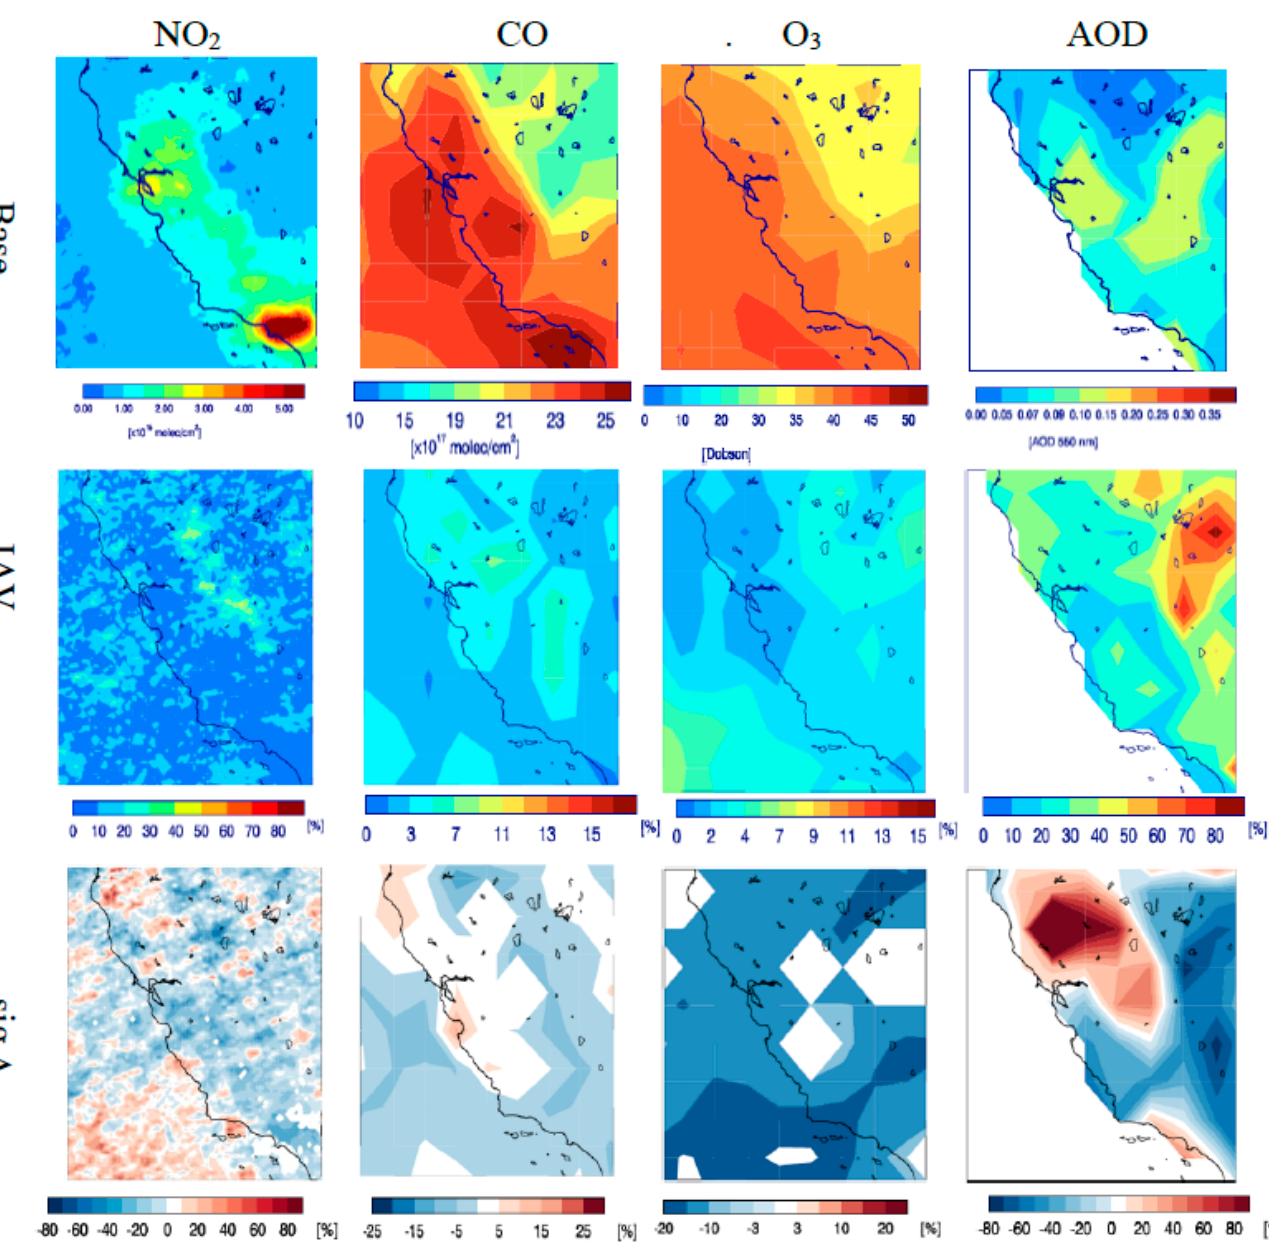
Figure 10. Same as Figure 3 but for the western coast. Tropospheric ozone column levels can reach up to 43 DU on the western coast with relatively low IAV of up to 1%–2% on San Francisco and Los Angeles. Reductions in the ozone tropospheric column during the lockdown period is within 15% over San Francisco and Los Angeles (see Figures 5 and 10). As aforementioned, ozone is a photochemical product, and the increase of NO 2 (north of San Francisco) under high-NO x conditions also decreases O 3 formation. AOD IAV during the base period (2010–2019) ranges between 10% and 30% over the western coast. However, there was a significant increase of AOD of up to 80% over San Francisco and to a much less extent of up to 30% over Los Angeles. Since these increases in AOD were not directly related to the reduced traffic volume during the pandemic, we report that ETR(AOD) was ≤ 0 over